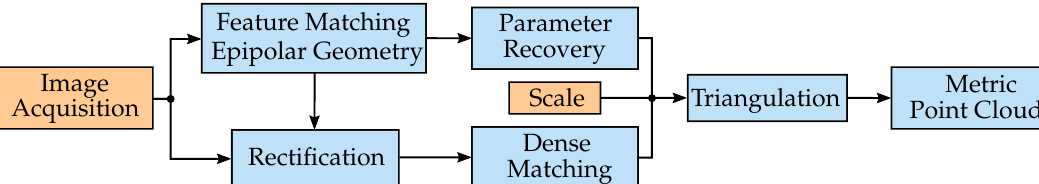
Figure 1. Schematic of the reconstruction routine’s processing steps. Data that is given to the pipeline is coloured in light red, the algorithmic processing of the data is depicted in blue.